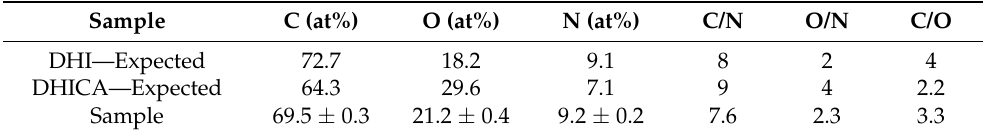
Table 2. The atomic composition (atomic concentration %) and atomic ratios determined from pressed powder pellets of the synthetic melanin sample. For comparison, the expected ratios for the monomer building blocks DHI and DHICA are shown. We note that hydrogen is not included since XPS is unable to extract hydrogen content from